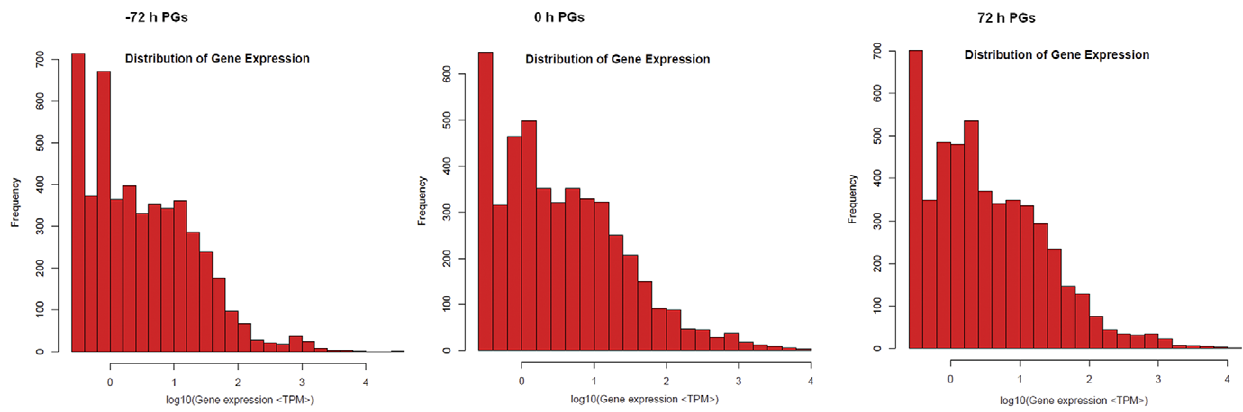
Figure 3. Distribution of gene expression. Gene expression level determined by calculating the number of unambiguous tags and then normalizing to TPM (transcript copies/million tags).